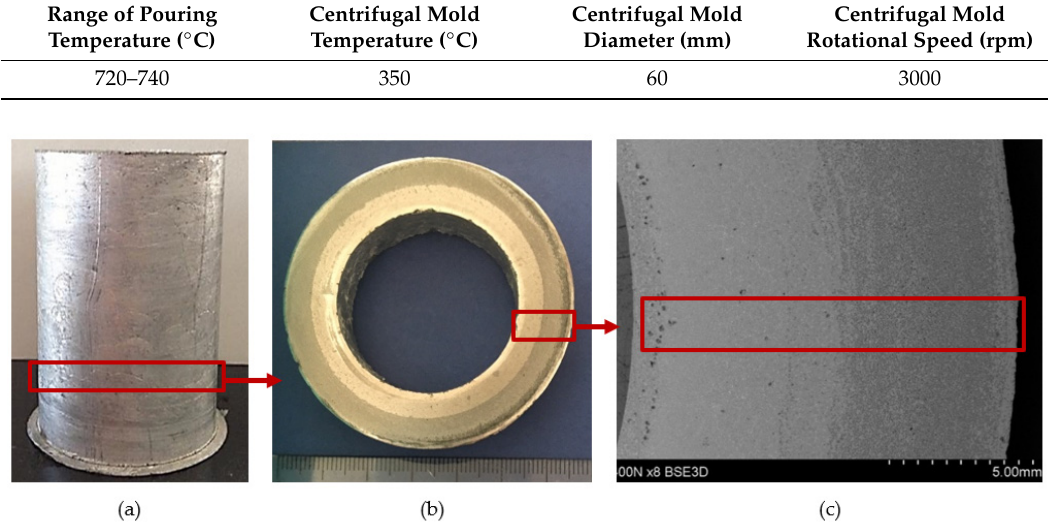
Figure 4. A centrifugal casting of a composite suspension based on AlSi12 alloy with 10% by weight share of SiC p : ( a ) a view of the casting in the form of a sleeve; ( b ) a view of ring cut out from the lower portion of the sleeve; ( c ) macrostructure of a ring fragment with reinforcement distribution visible on its cross-section. Unetched section.